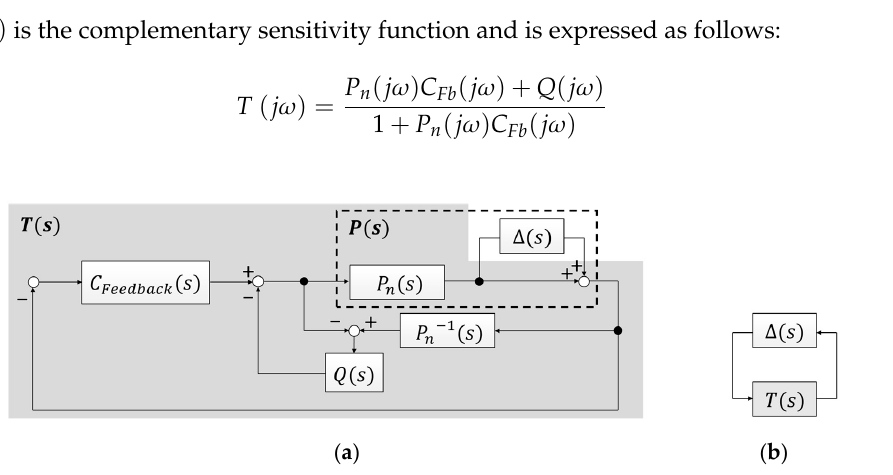
Figure 6. Block diagram of proposed control system: ( a ) Block diagram of the closed-loop control system with multiplicative model uncertainty; ( b ) Equivalent block diagram.